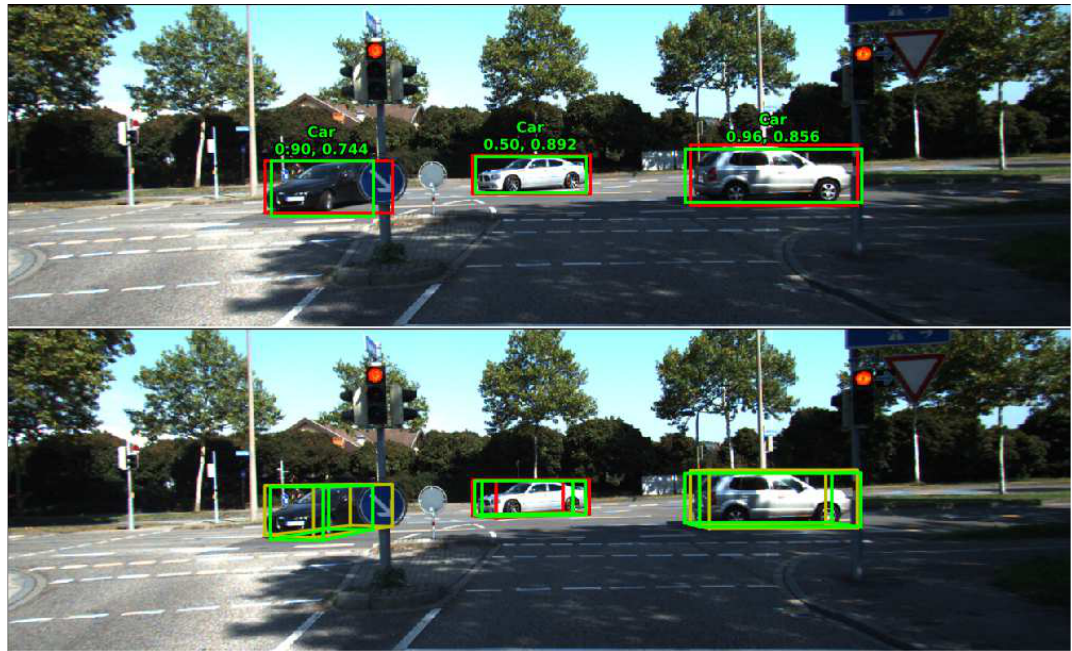
Figure 6. ( Top ) The detection results are projected onto 2D images (the values are detection accuracy and IoU); and( Bottom ) the 3D box is projected onto the image.